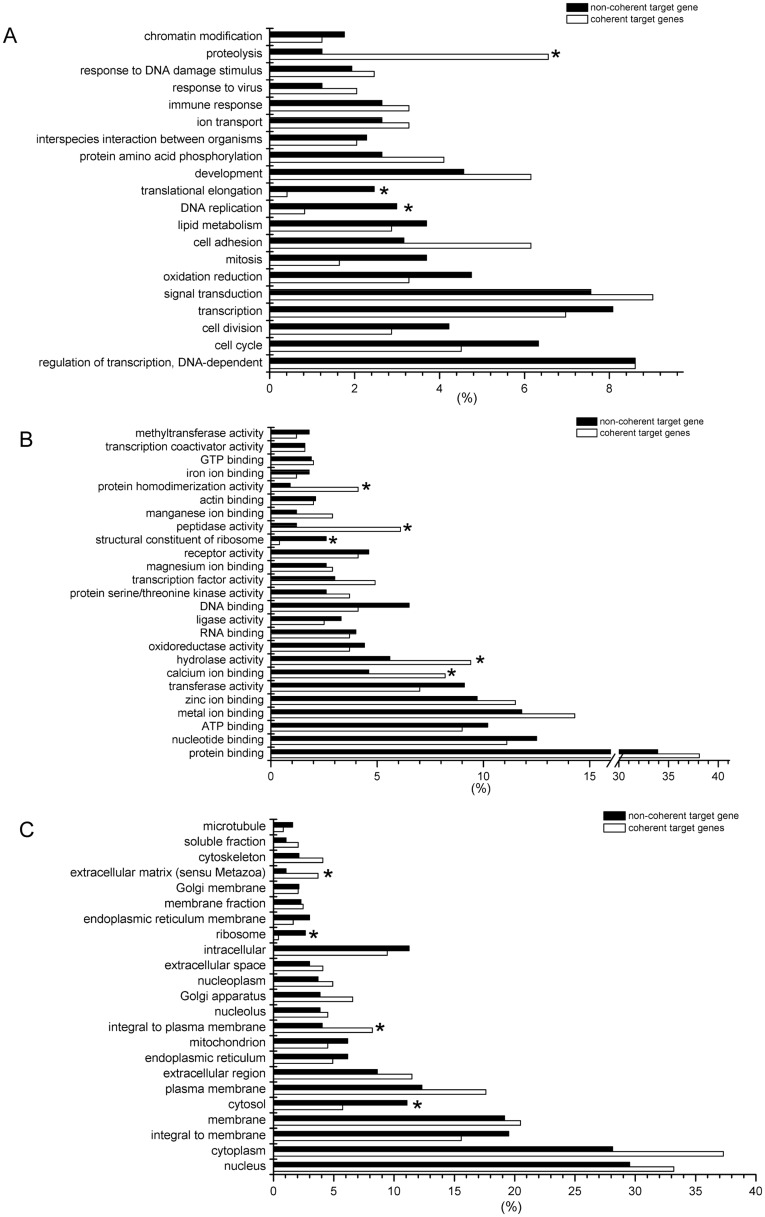
Gene ontology analysis of miRNA targeted DEGs and non-targeted DEGs.(A) biological process; (B) molecular function; and (C) cellular component. The x axis represents the percentages of genes in total targeted or non-targeted DEGs of each GO term. The p-values assigned to GO terms were calculated by chi-square test, * indicates p-value <0.05.